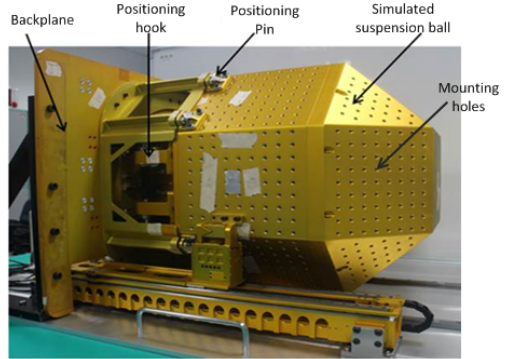
Figure 1. Space station suspension ball structure.